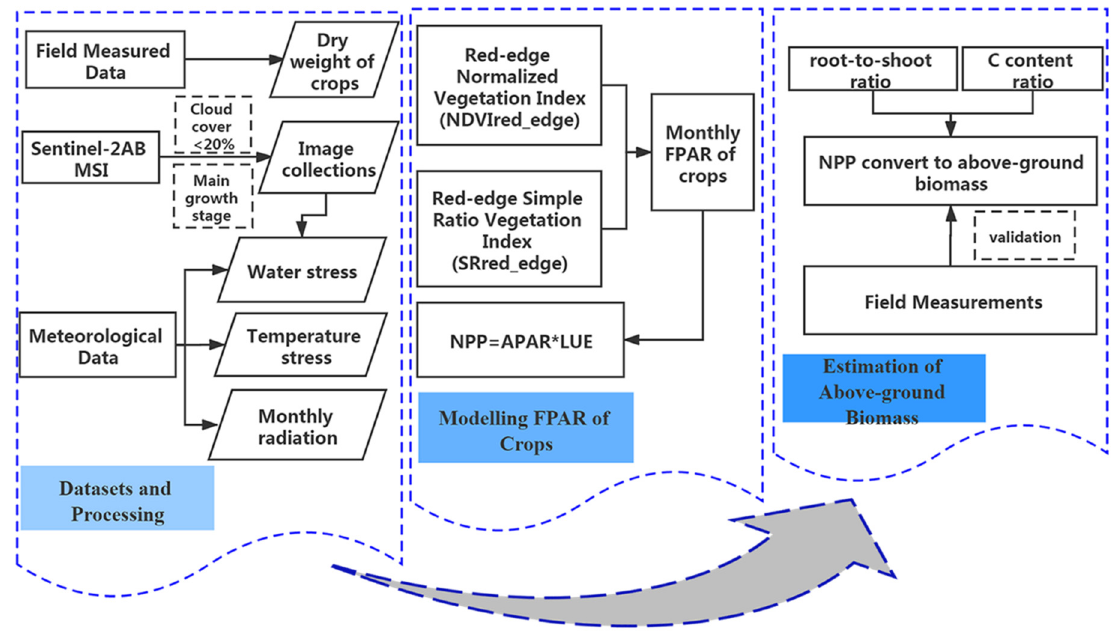
Figure 4. Workflow of this study.